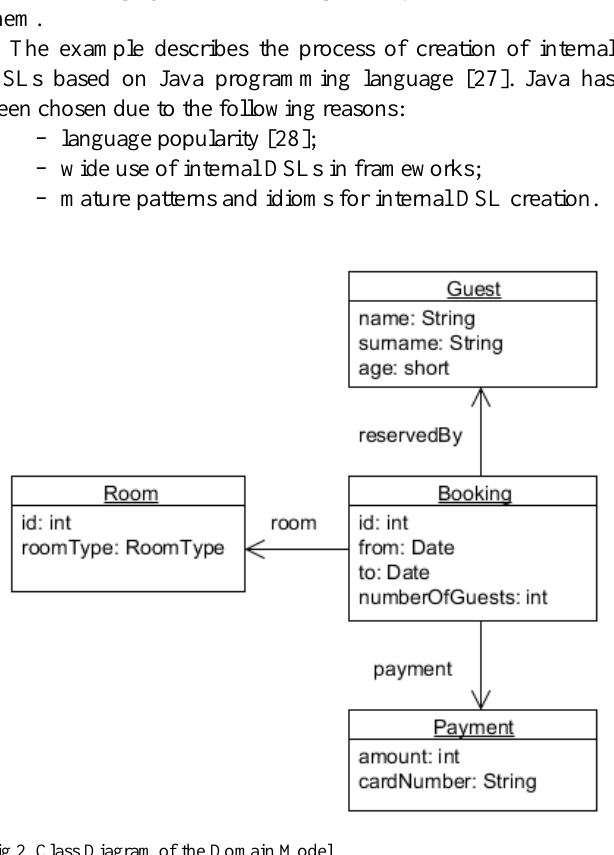
Fig.2. Class Diagram of the Domain